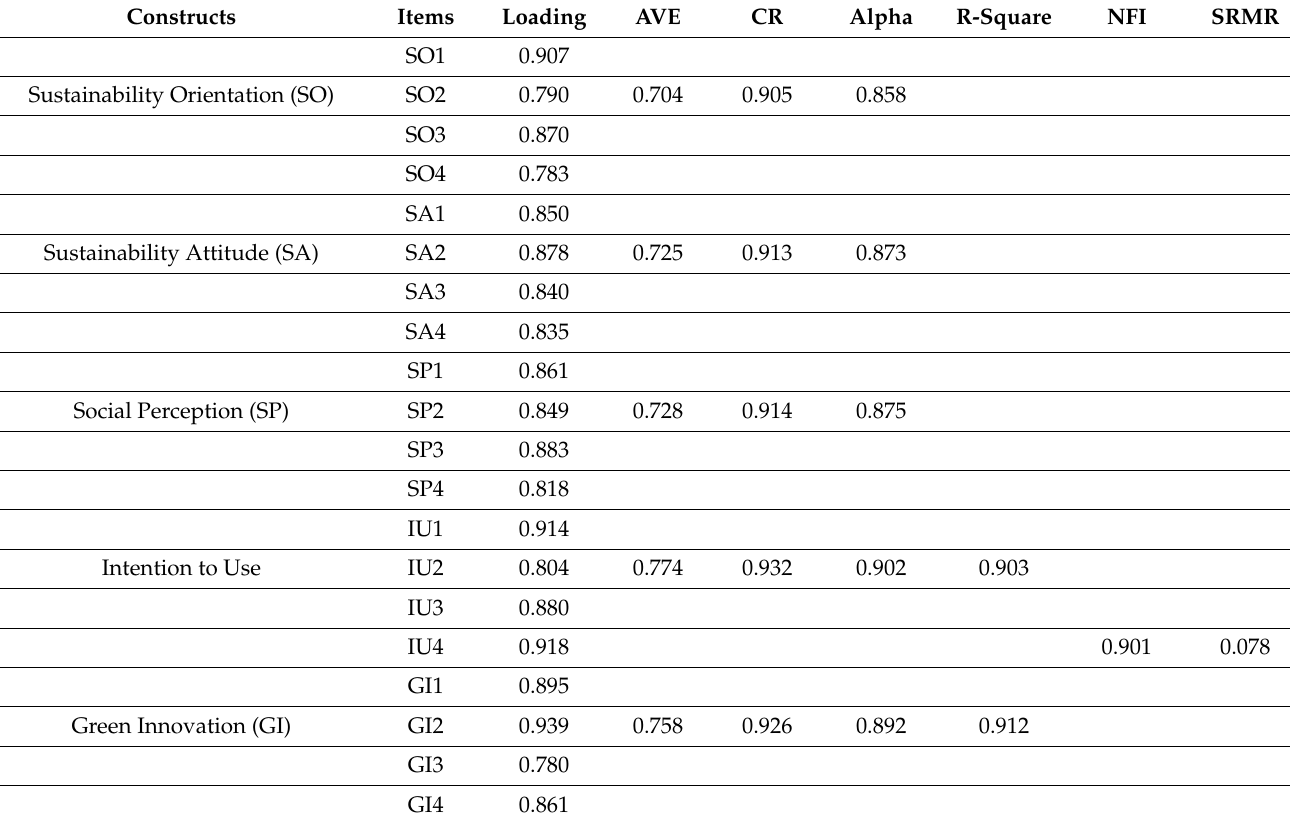
Table 2. Measurement of model assessment.